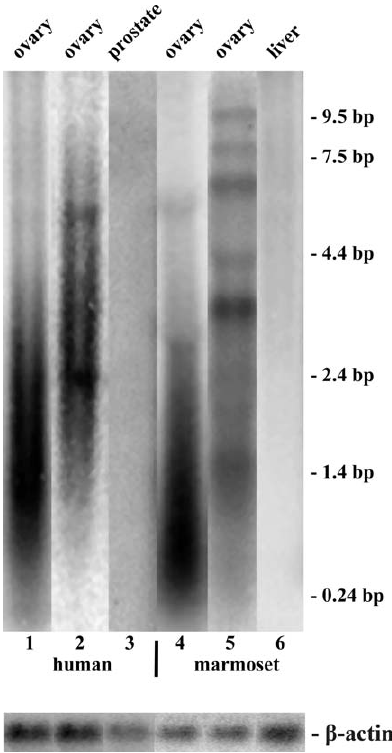
Figure 5. Exon 6A-Specific Transcripts as Detected by Northern Blot Hybridization Commercially available Northern blots containing human adult normal tissues and Northern blots from adult marmoset tissues were sequen- tially hybridized to an exon 6A probe or the human full-length LHCGR cDNA. Lanes 1 and 4, exon 6A probe. Lanes 2 and 5, full-length LHCGR cDNA probe. Lanes 3 and 6, negative control tissues hybridized either to LHCGR cDNA (lane 3) or to exon 6A (lane 6). Blots were exposed for 1–6 h using a Phosphorimager. An RNA marker was used for size determination of the different transcripts. One Northern blot hybridization out of three independent experiments is shown. While a range of discrete transcripts is identified using the full-length LHCGR cDNA probe, a comet-like hybridization pattern, probably representing degraded mRNA tran- scripts, is detected by an exon 6A-specific probe. These results indicate that (i) transcripts containing exon 6A are naturally present in the ovary and (ii) they undergo massive degradation, possibly by NMD. b -actin hybridization results are given to demonstrate RNA